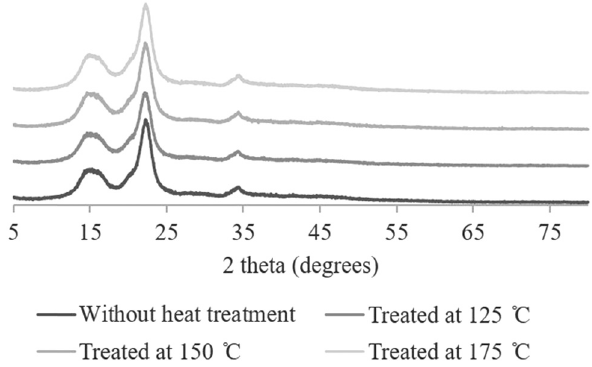
Figure 2: Di ff ractograms of MCC powder without heat treatment and heat treated at 125°C, 150°C, and 175°C.